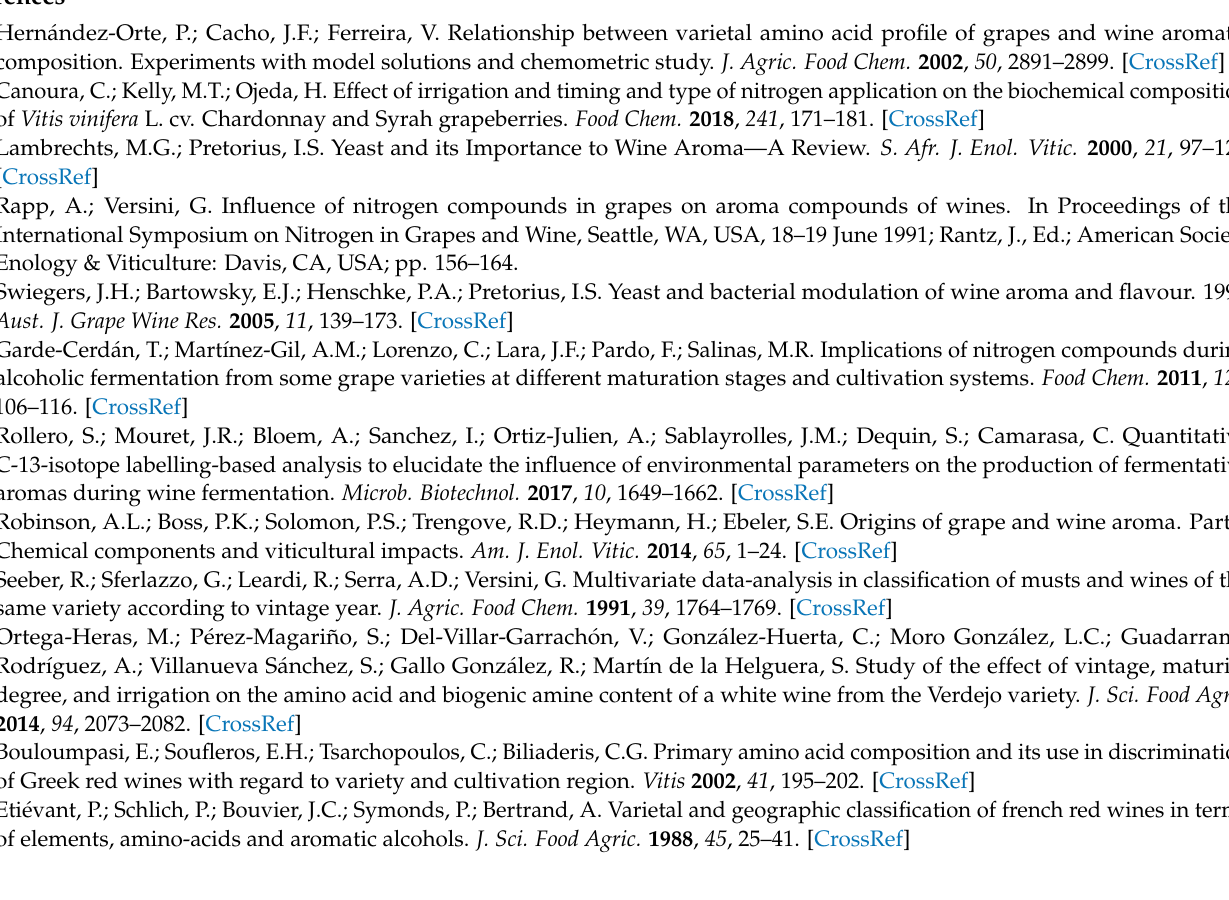
(s); Figure S1: Evolution of some varietal aroma compounds and pH during maturation in mistelle samples aged 8 months. 3A, TDN; 3B, γ -nonalactone; 3C, ethyl vanillate; 3D, pH; Table S5: Corre- lations between amino acid consumed proportions and the quotients 1/GABA, ALA/GABA and GLU/GABA in must. References [51–55] are cited in the supplementary